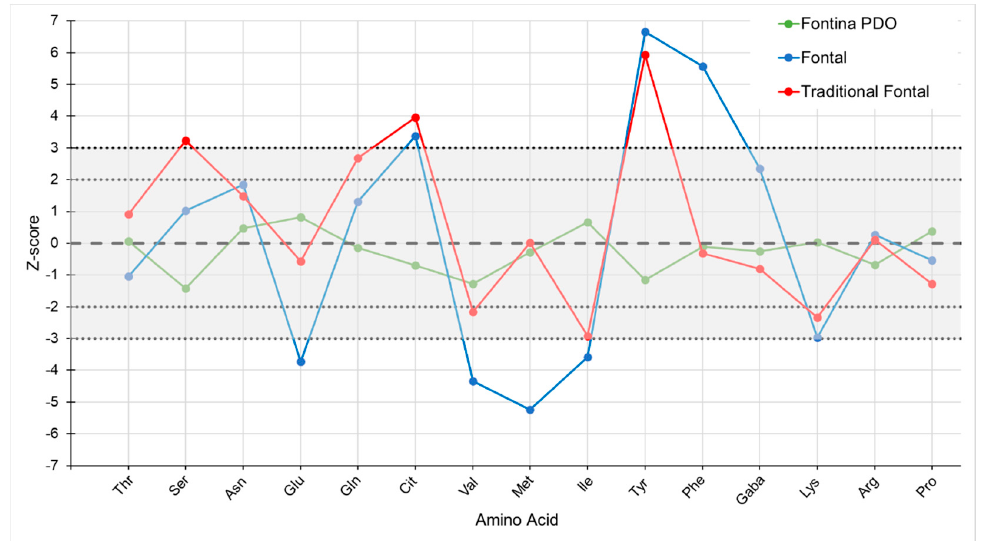
Figure 4. Chemometric model for Fontina PDO cheese based on the profile of 15 free amino acids: behavior of three commercial samples. The grey shaded area identifies the region of authenticity of Fontina PDO cheese.